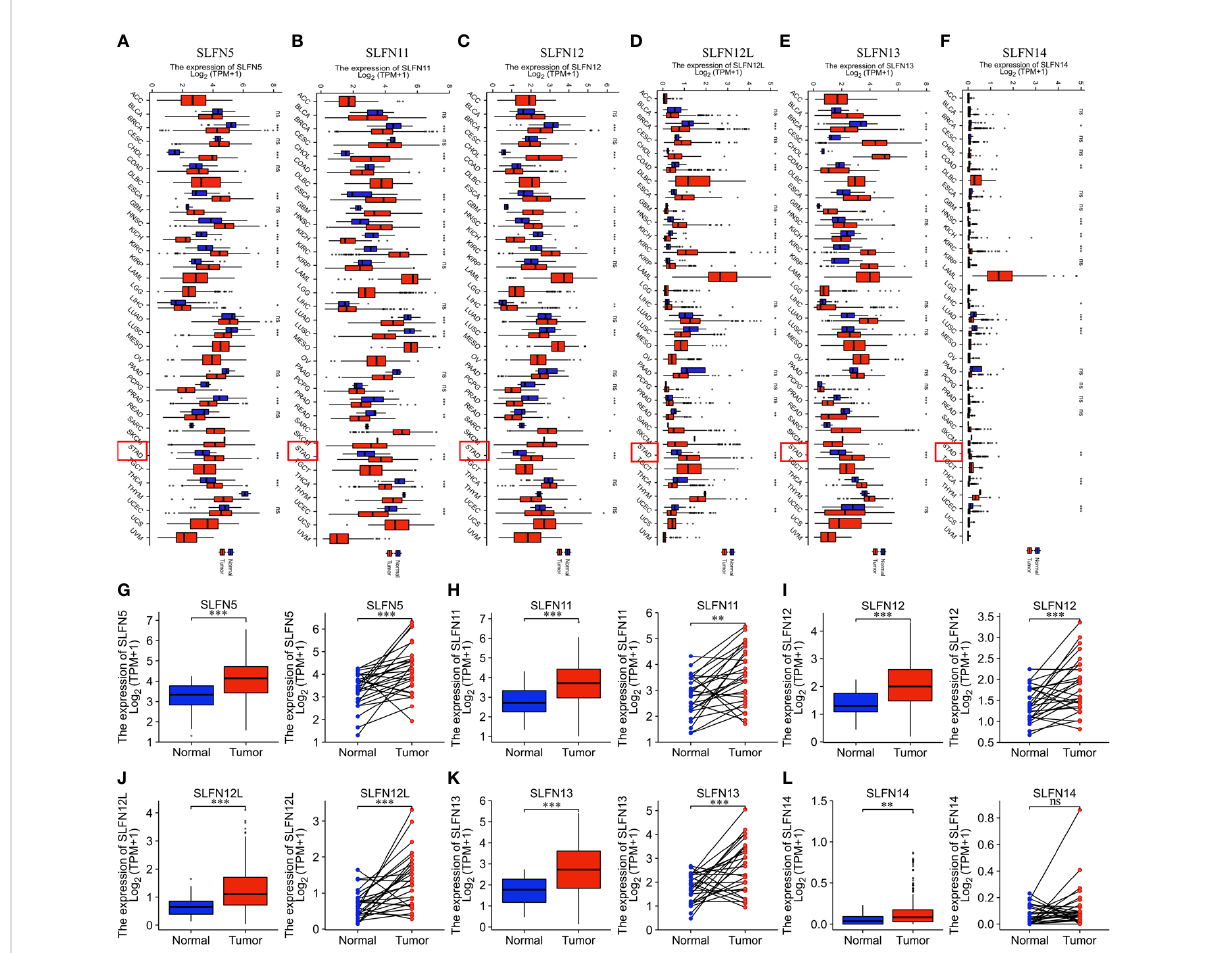
FIGURE 1 SLFNfamilymembersarehighly expressedingastriccancer. (A – F) Increasedexpression of SLFNfamily membersinpan-cancer. (A) mRNAexpressionof SLFN5indifferent tumors. (B) mRNAexpressionof SLFN11indifferent tumors. (C) mRNAexpressionofSLFN12 indifferenttumors. (D) mRNAexpressionof SLFN12Lin pan-cancer. (E) mRNAexpressionof SLFN13inpan-cancer. (F) mRNAexpressionof SLFN5inpan-cancer. (G – L) PairedandunpairedmRNA expressionsof differentSLFNfamily membersingastriccancertissuesandnormal gastricmucosatissues. (G-K) Thepairedandunpaired expressionsof SLFN5, SLFN11, SLFN12, SLFN12L, andSLFN13intumorswerehigherthannormal. (L) SLFN14expression washigherintumorsthan innormal tissues, but there wasnodifferenceinSLFN14 expressioninpairedtissues. *p <0.05, **p <0.01, ***p< 0.001and****p< 0.0001andnsmeansnosigni fi